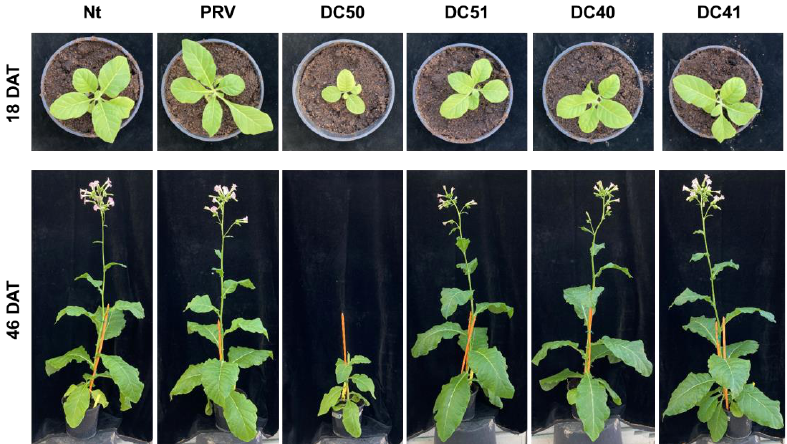
Figure 3. Plant phenotype. Greenhouse-grown transplastomic plants expressing TrAA9B (DC50 and DC51) and TaAA9B (DC40 and DC41) proteins compared to controls (Nt and PRV, wild type and transformed with the empty vector, respectively) at 18 and 46 days after transplanting (DAT).